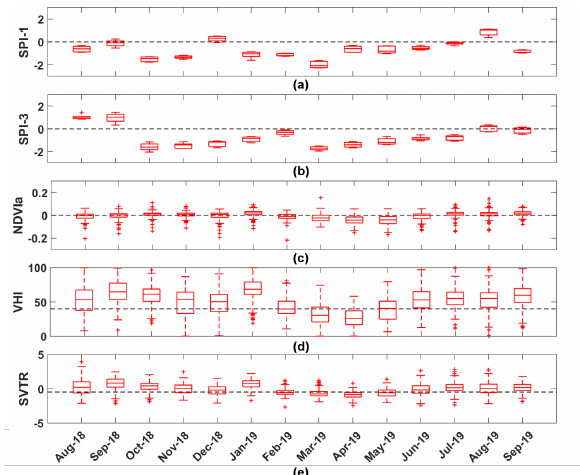
Figure 6. Drought temporal evolution in drought-affected province of Occidental Mindoro, as indicated by the boxplot